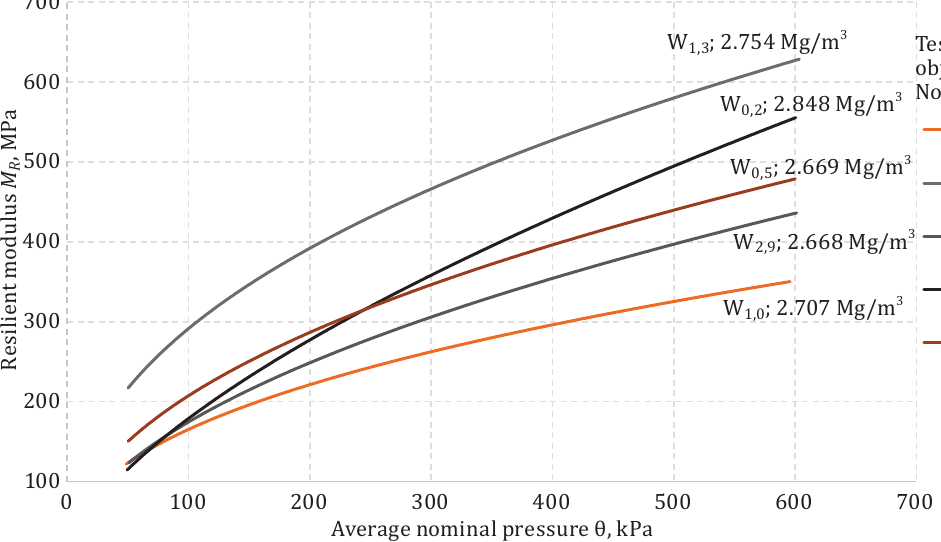
Figure 3. Effect of aggregates density and water absorption on mixture resilient modulus within different average nominal